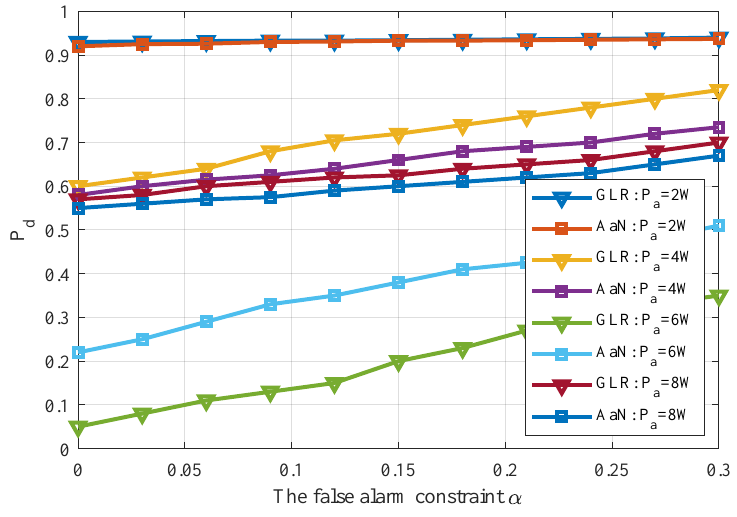
Figure 8. Detection performance under different false-alarm constraints, which can reflect the compromise between false alarm probability and detection